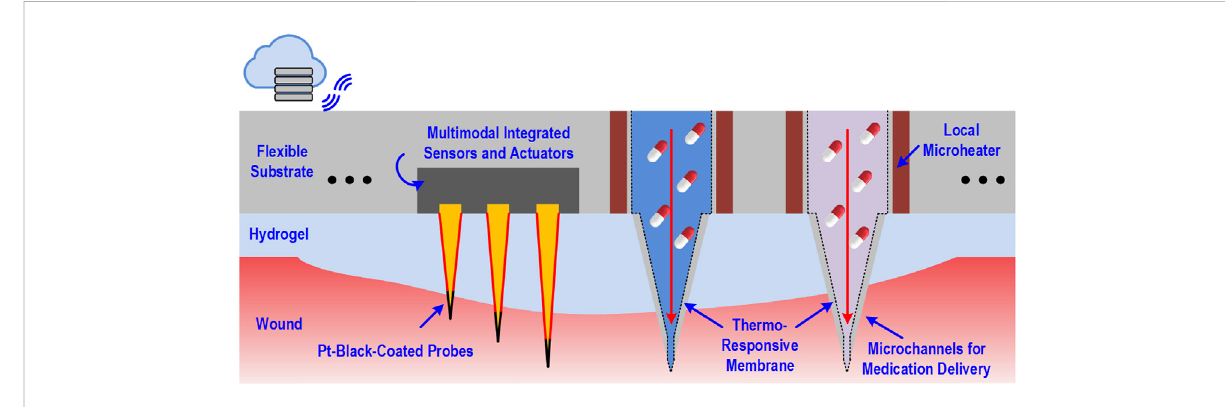
FIGURE 2 Schematic of dressing-impregnated microchip with simultaneous biosensing and medication delivery